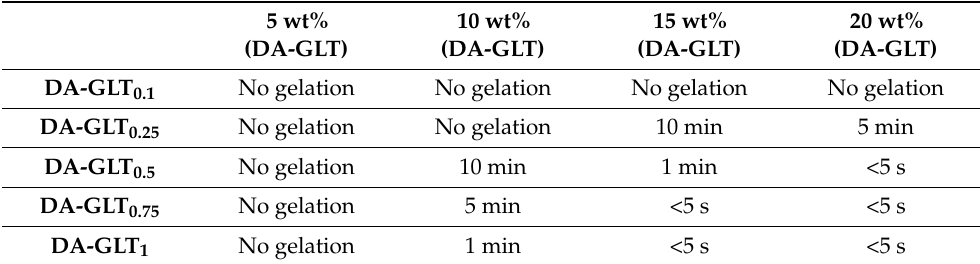
Table 1. Gelation time of different DA-GLT at different contents of DA-GLT (the weight ratio of DA-GLT to AgNO 3 in feed is fixed at